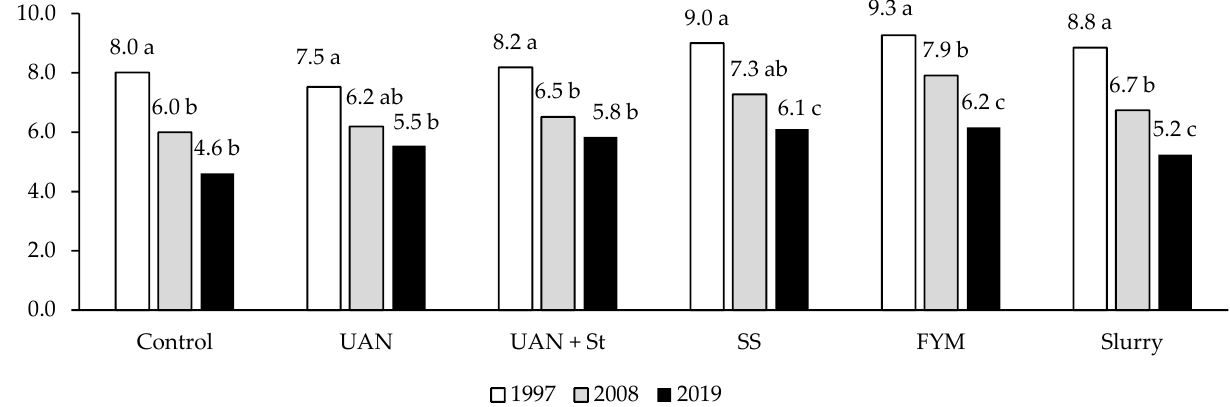
Figure 4. Content of adsorbed sulfur fraction (S ads ) in topsoil. Different letters describe significant differences between years within the treatment. Tukey HSD test ( p < 0.05), ( n = 4).